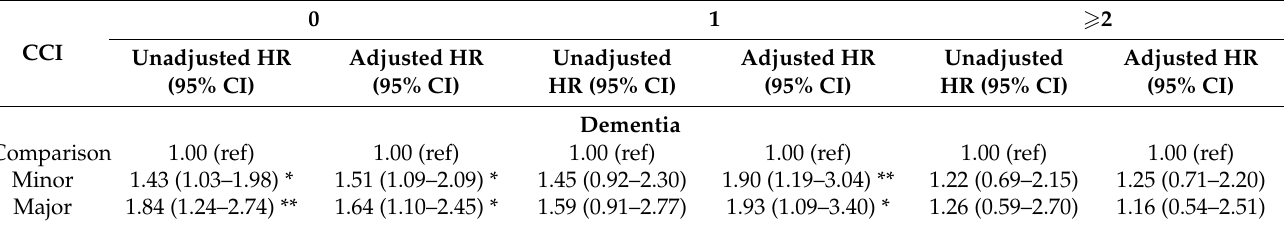
Table A8. Hazard ratios of dementia by CCI among surgery type according to surgery scale.